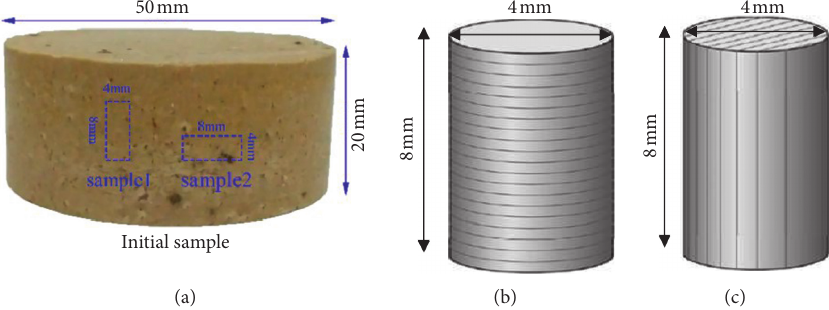
Figure 1: Illustration of the prepared GMZ bentonite samples: (a) photo of the specimen, (b) sample No. 1, and (c) sample No.